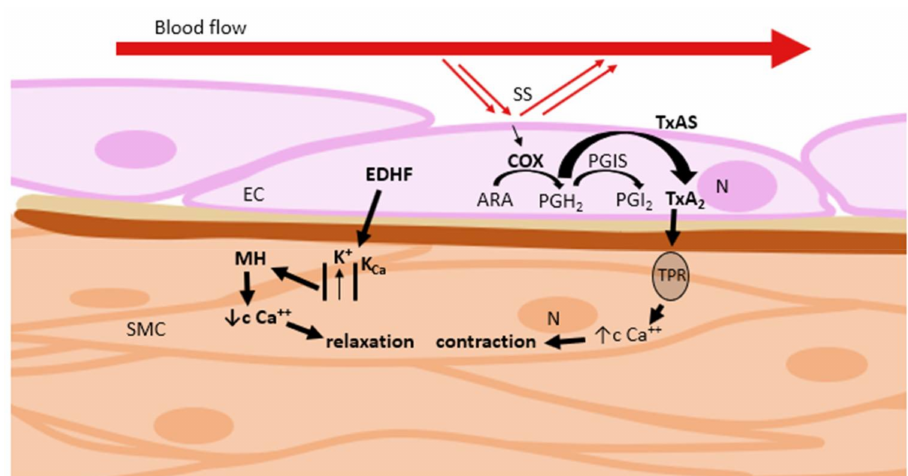
Figure 8. Regulation of vascular tone via activation of K + channels or inhibition of intracellular Ca